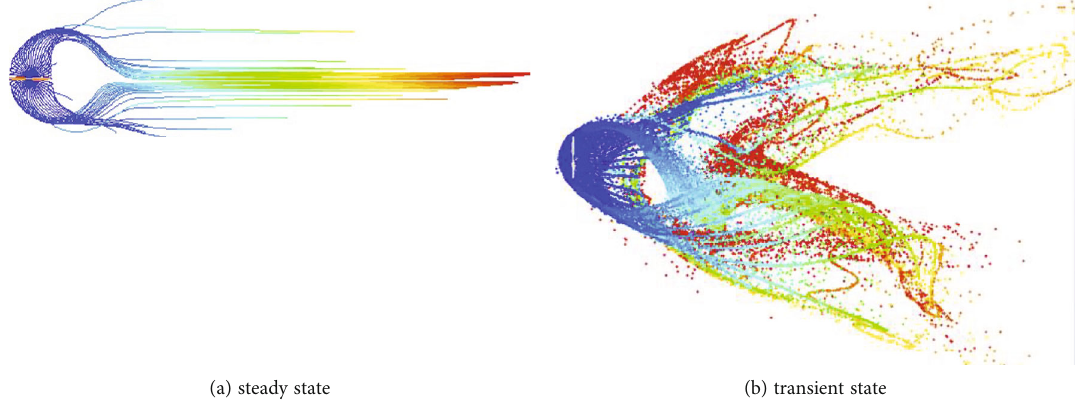
Figure 11: Droplets trajectory of single-rotor when the free-stream velocity is